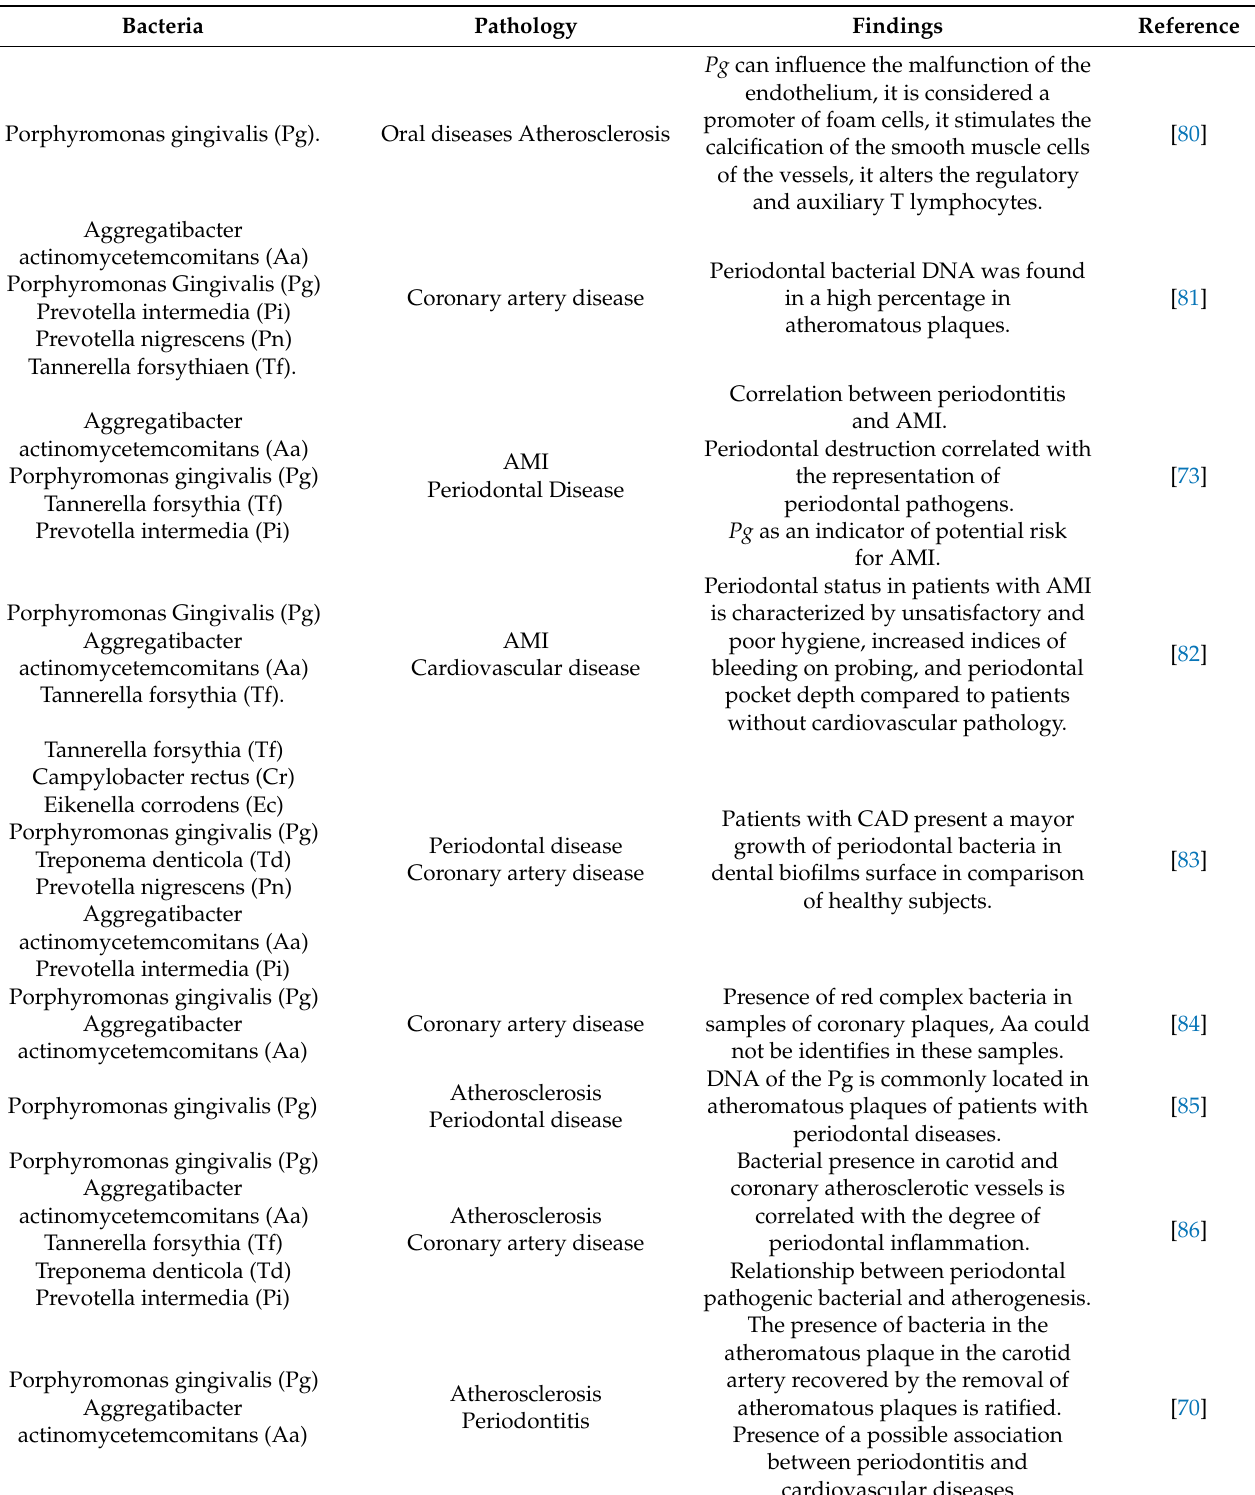
Table 2. Pathogens involved in the development of periodontitis and